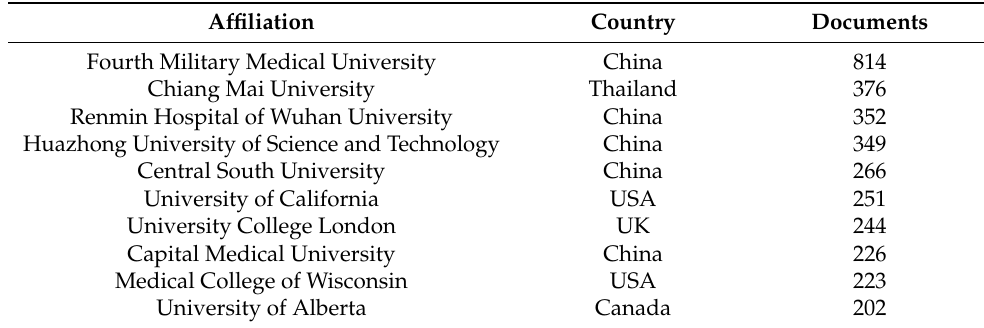
Table 1. Top 10 affiliations with most publications related to myocardial reperfusion injury.